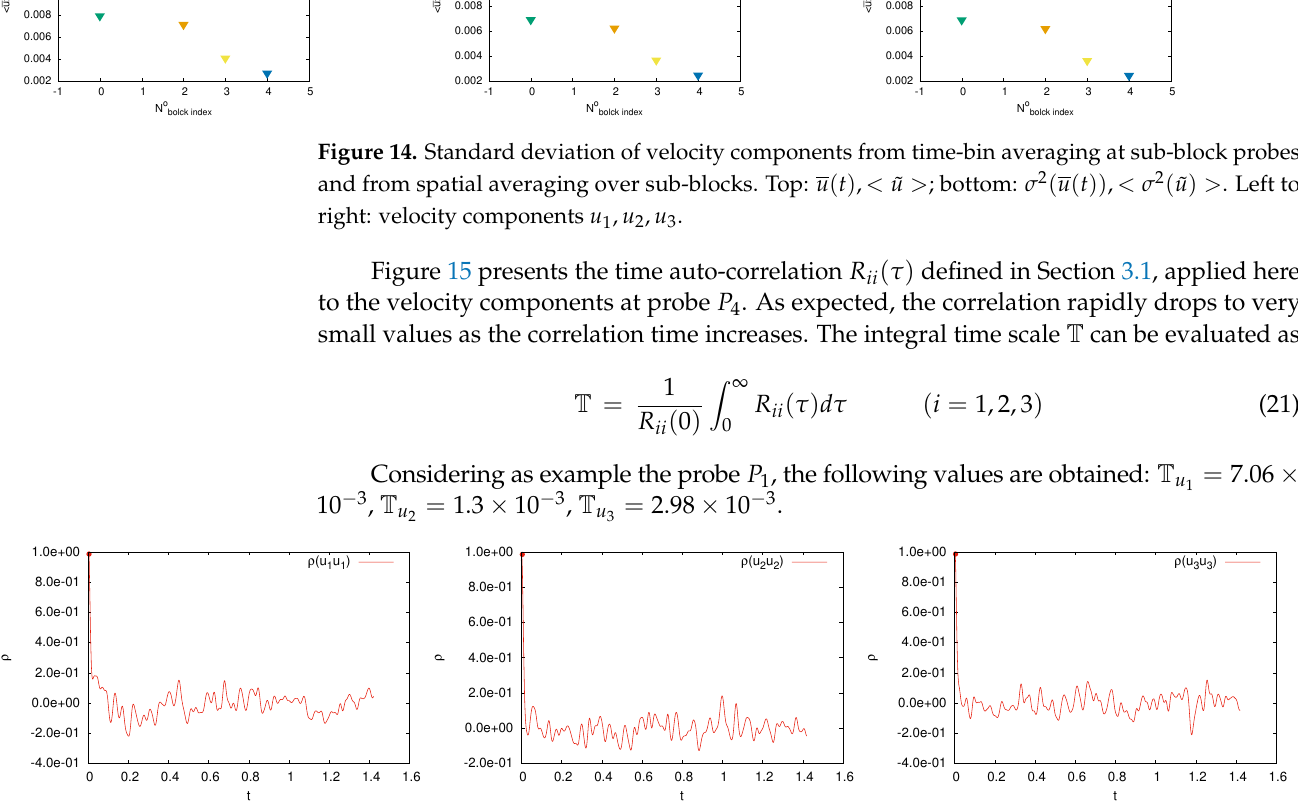
Figure 15. Probe no. 4: time auto-correlation R ii ( τ ) of the velocity components u 1 ( left ), u 2 ( center ), u 3 ( right